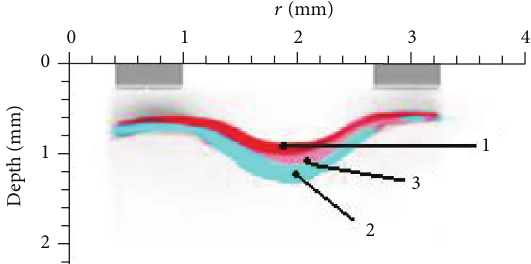
Figure 7: The most probable path distribution between two sources for fluorescent and diffusely scattered photons (excitation wave- length, 532 nm; distance between fibres, 1.7 mm). 1—fluorescent photons,2—diffuselyscatteredphotons,and3—intersectionof1and 2.